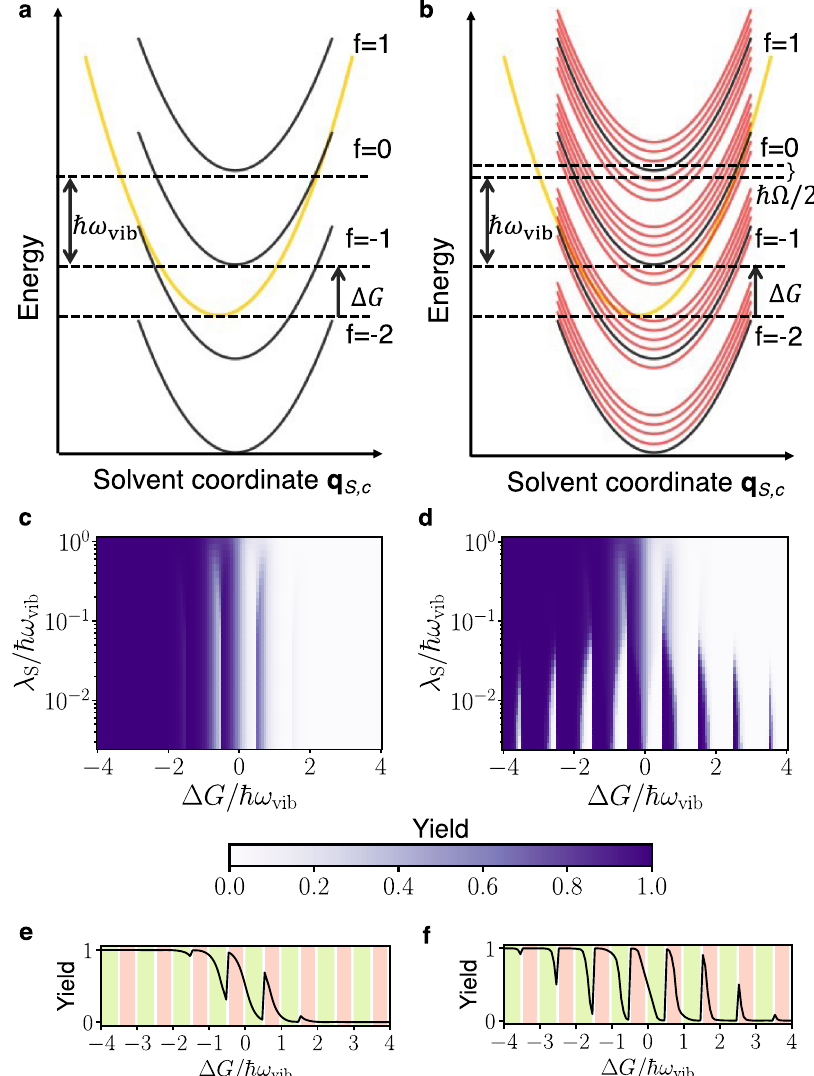
Fig. 4 Potential energy surfaces (not to scale) and reaction yield. a , c , e are results for a laser-driven system without light-matter strong coupling (SC) and b , d , f are for the same system under SC and 2.4% of the population in the lower polariton (condensation). All these plots are for symmetric light- matter coupling g R = g P . a , b For a clearer qualitative picture, we plot the PESs under zero detuning Δ = 0. Initial (yellow) and fi nal (black) PESs for a molecule undergoing the forward reaction with solvent coordinate q S,c . While the energy separation between black PESs is ℏ ω vib , the condensate provides = N at temperature k = 0.1389 ℏ ω = 298 K when many additional fi nal PESs (red, separated by ℏ Ω /2 at resonance). c Reaction yield N ss B T vib ( T P ℏ ω = 185 meV), Huang – Rhys factor S = 3.5, and average occupation of the intramolecular vibrational mode (cid:2) n ¼ 0 : 08. d Reaction yield N ss = N with ffiffiffiffi p ffiffiffiffi p vib P ¼ 2 g ¼ 0 : 1 ω Δ = − 0.0695 ω N N , P − = 0.08 N Γ ↓ , N = 10 7 , temperature and Huang – Rhys factor are the same as c . The contributions of the vib , 2 g R P vib red PESs through the condensate provide a broader tunability of reaction yields with respect to Δ G than under laser driving without SC. Notice that originally endergonic (exergonic) reactions in the absence of optical pumping can become exergonic (endergonic) under the featured nonequilibrium conditions. e , f A cross-section of plot ( c , d ) when λ S = 10 − 2 ℏ ω vib . The pink shaded regions correspond to cases where the dominant forward (backward) channel is in the inverted (normal) regime; the opposite is true for the green shaded regions. The condensate ampli fi es the forward (backward) reaction in the pink (green) shaded